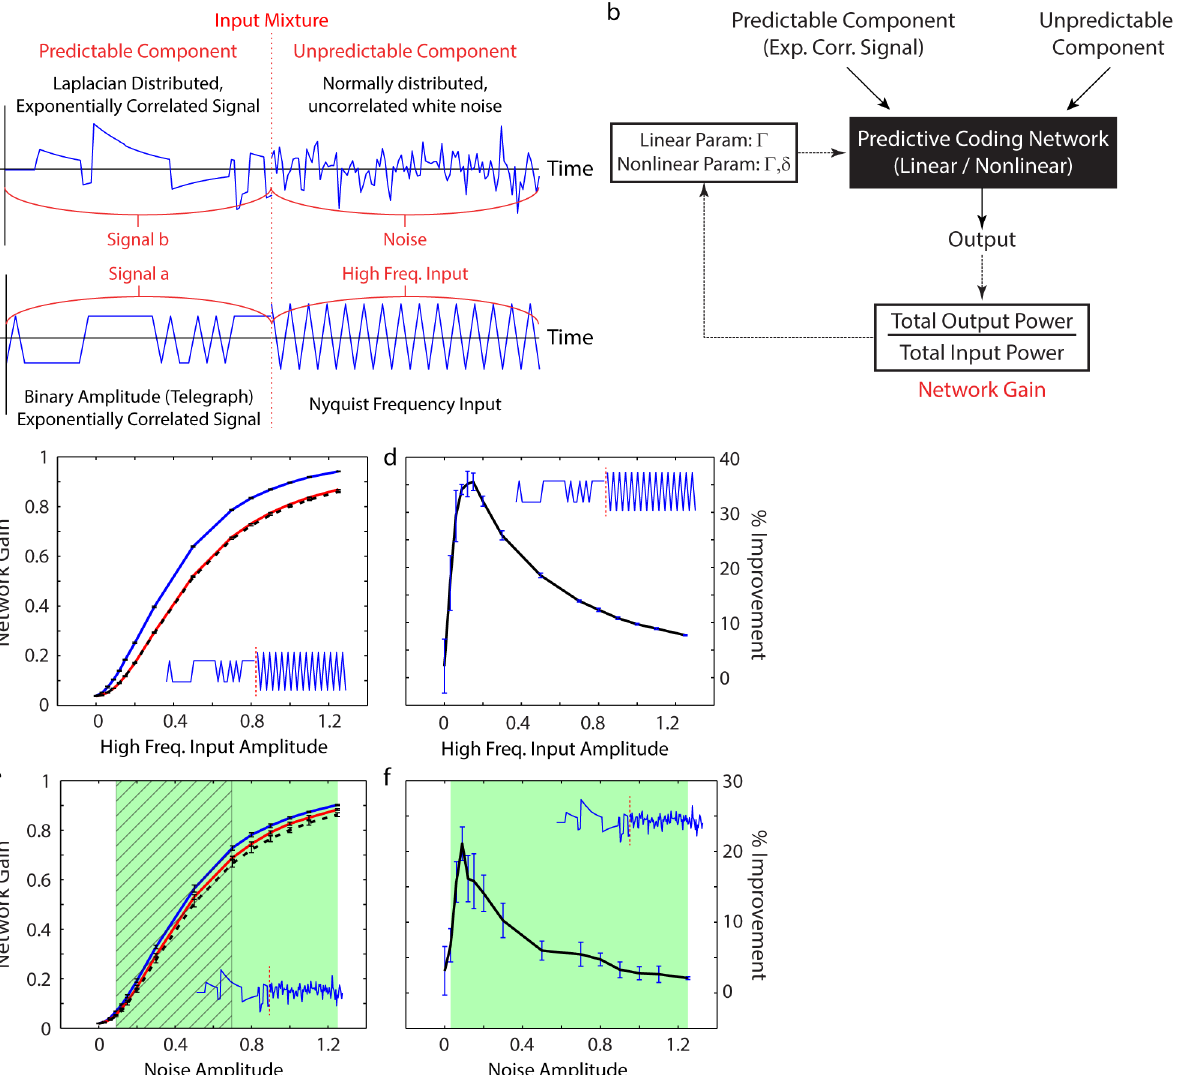
Fig 5. Comparing the performance (measured through network gain) of nonlinear and linear feedback inhibitory networks (measured through network gain: lower is better) (details in Methods). (a) Two input mixtures, modeling rapid transition from predictable to unpredictable input components. (b) Description of simulations. Inputs constructed as in (a). At each time point, inputs are either pure predictable signal, or pure unpredictable noise, with an instantaneous transition from one type to the other, in the middle of the simulation period. (c-f) Simulation outputs (inputs shown in inset). The amplitude of the unpredictable component of the mixture varies along the x axis. Error bars are 1 std. dev. (c,e) Network gain of the linear network of type 1, optimized to the mixture (blue, non-adapted linear response), is significantly higher than that of the nonlinear network (red). In contrast, the nonlinear network gain is close to the response of the optimal linear network of type 2, which is allowed to adapt to each component of the mixture (dotted black, adapted linear response). (e) Green shading indicates region where the nonlinear response is more than one std. dev. lower than the non-adapted linear response. Diagonal hashing indicates region where the nonlinear response is within one std. dev. of the adapted linear response. (d,f) % improvement of the performance of the nonlinear network over the type 1 linear network at different amplitudes of the unpredictable component. Data taken from (c) and (e) respectively. (f) Green box indicates region where the improvement is more than one std. dev. different from